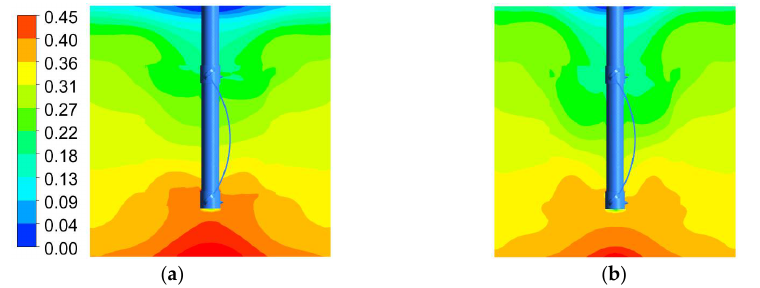
Figure 15. The schematic diagram of DRFTBI strengthens the solid suspension.